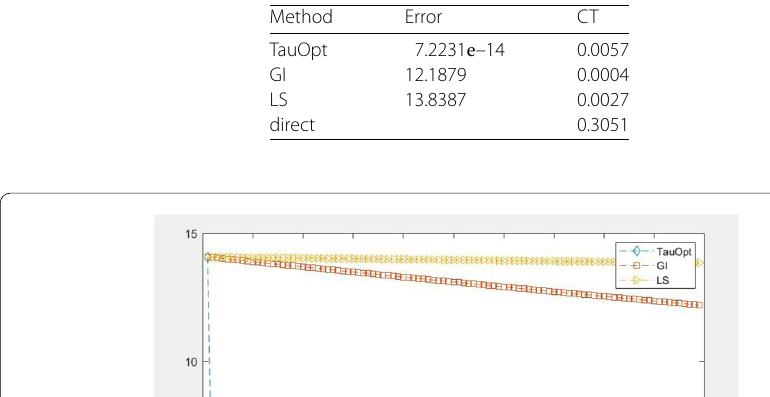
Table 1 Error and CT for Example 5.1